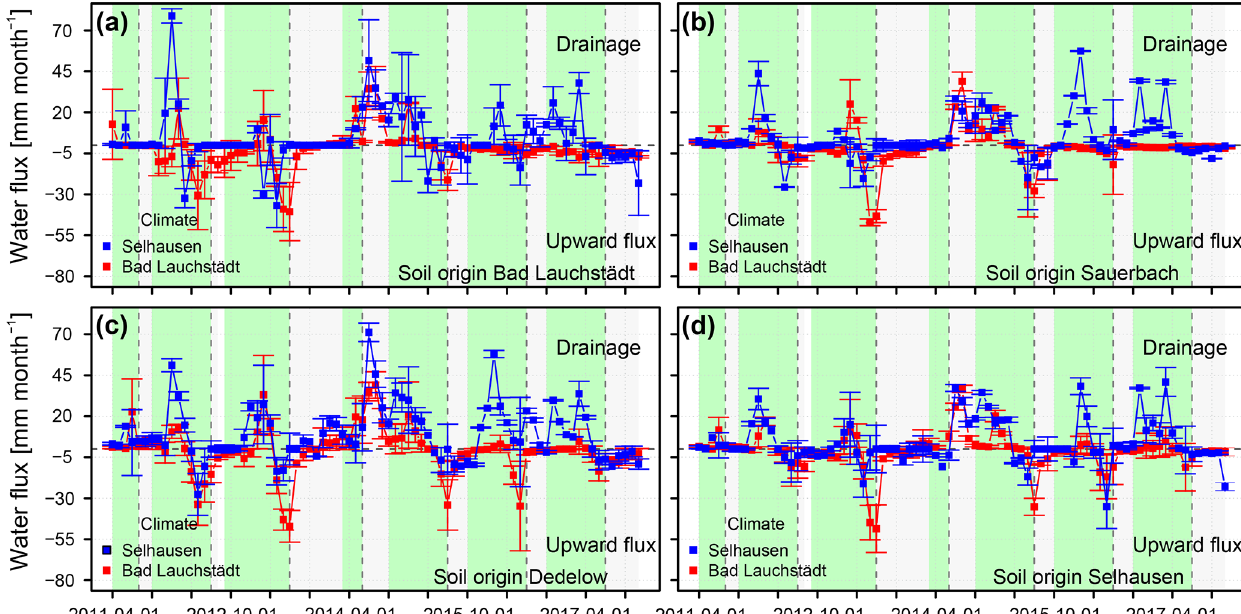
Figure 3. Monthly net water fluxes across the lysimeter bottom in 1.5m soil depth from April 2011 until January 2018 at the stations Selhausen and Bad Lauchstädt for soils from (a) Bad Lauchstädt, (b) Sauerbach, (c) Dedelow and (d) Selhausen; mean values (dots) and standard deviations (error bars) are shown. Positive values are defined as drainage, and negative values are defined as upward-directed water flux from capillary rise. Error bars indicate the variability of storage changes between individual lysimeters of each soil group. The background colour corresponds to different crops lysimeter cover types: bare soil (white) and different crops (green). Dates are given in the figure in the YYYY-MM-DD